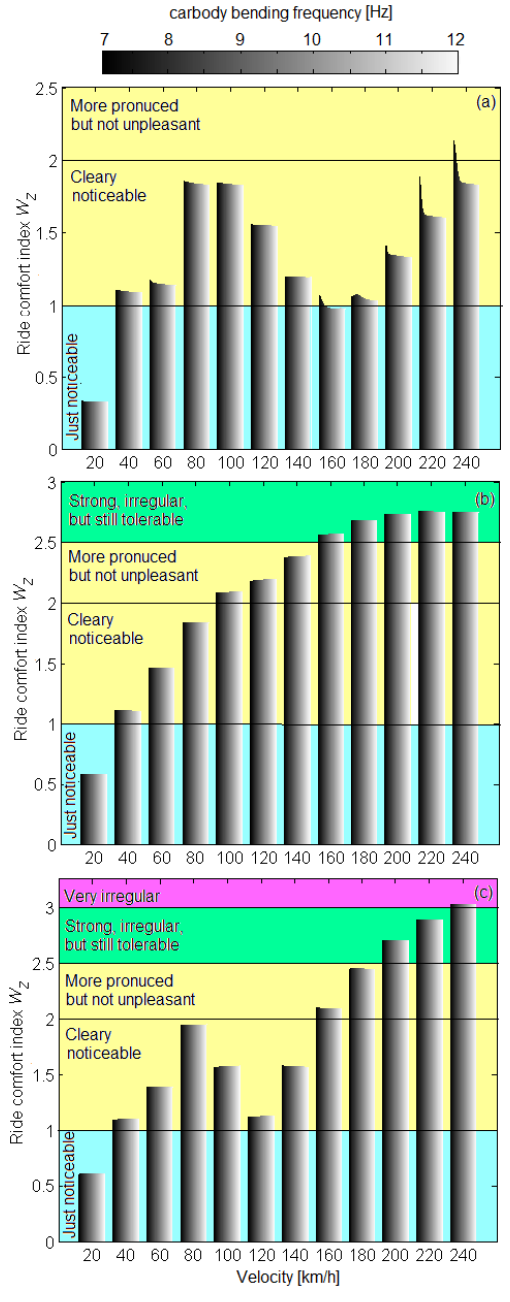
Figure 14. Ride comfort index Wz depending on the carbody bending frequency: ( a ) in point C ; ( b ) in point B 1 ;( c ) in point B 2 .